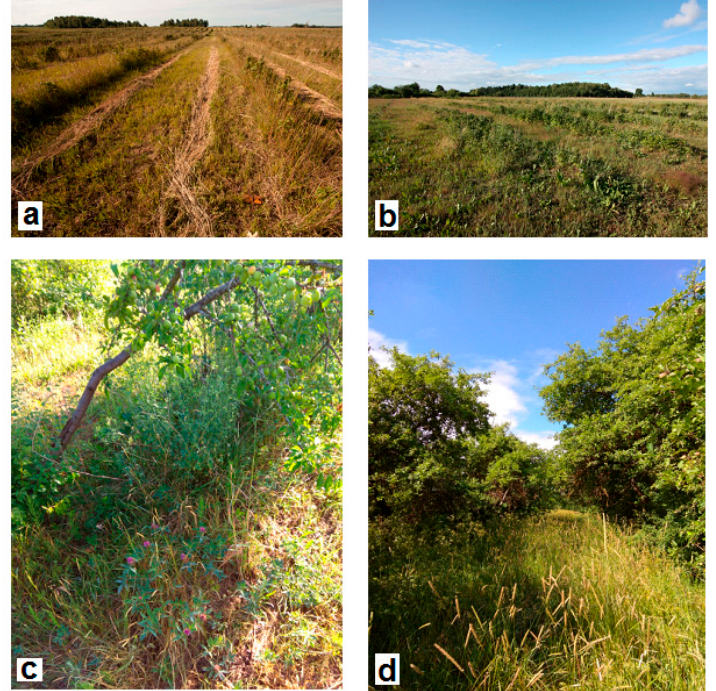
Figure A3. Research sites with low farming intensity: ( a ) currant plantation at site 3; ( b ) raspberry plantation at site 8; ( c ) plum fruit farm at site 11; and ( d ) apple fruit farm at site 7.